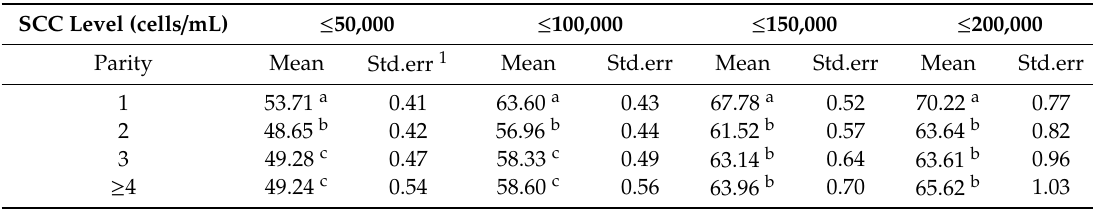
Table 4. Di ff erential leukocyte count (DSCC) mean and standard error in healthy subset ranked by Somatic Cell Count (SCC) levels. SCC Level (cells /